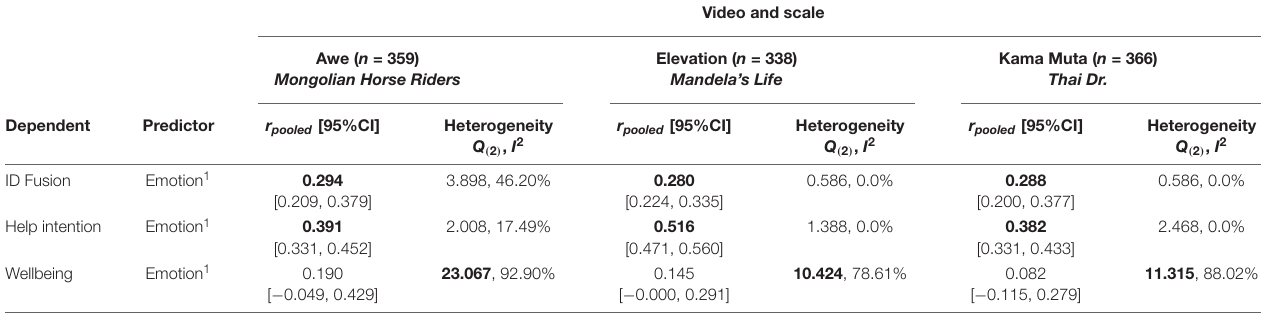
Video and scale